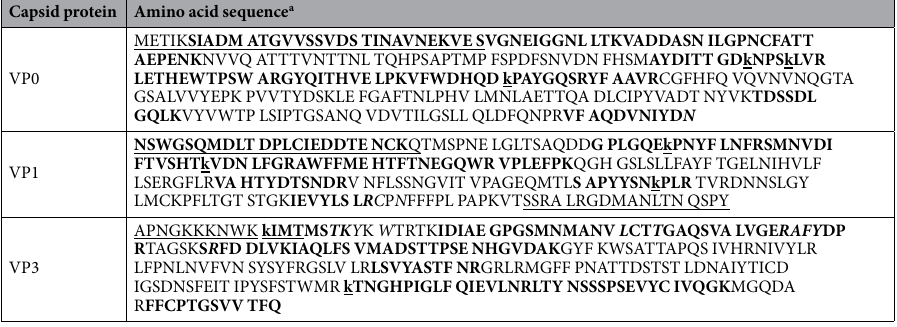
Table 1. Summary of regions from the HPeV1 virions that crosslinked to the encapsidated genomic RNA. a The residues from the twelve most intense peaks identified are in bold. The missed cleavages are shown in lower case letters and highlighted in bold-underline. The disordered regions not identified in the atomic model are underlined.